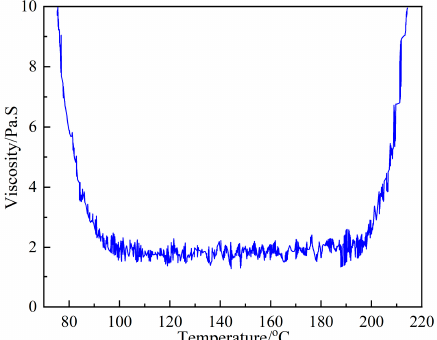
Figure 6. Viscosity–temperature curve of resin.